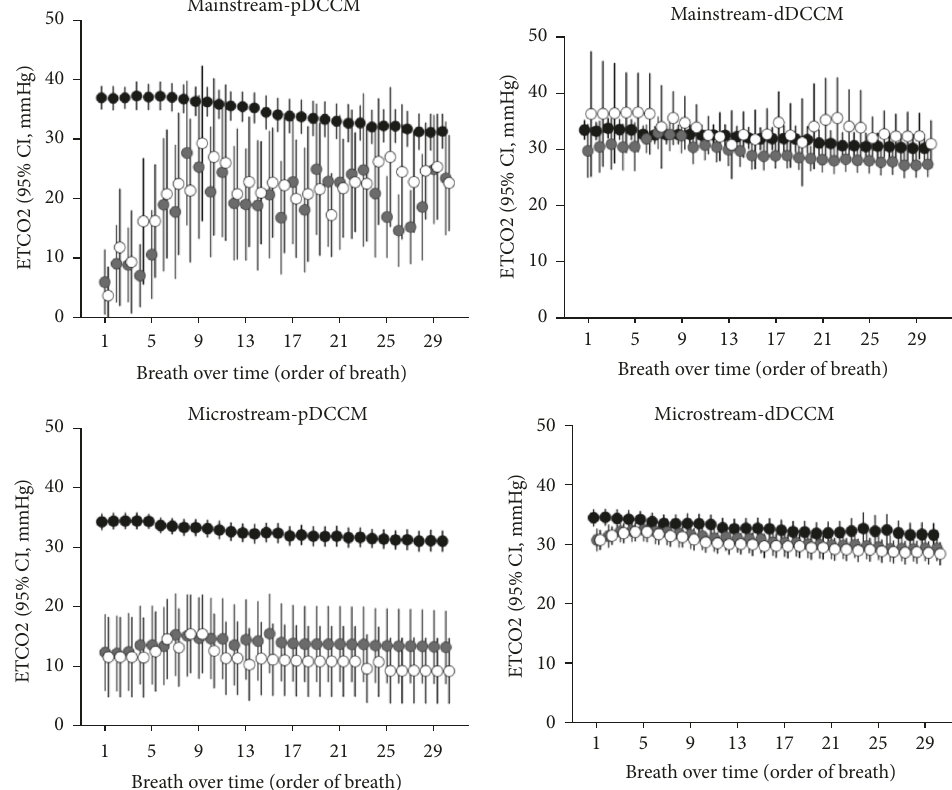
Figure 3: Individual ETCO for each breath over time measured by pDCCM and dDCCM under different water conditions (black circle - no 2 water, grey circle - 5 ml water, white circle - 10 ml water) created within the endotracheal tube . Individual ETCO2 values monitored from every breath over time were represented as mean with standard errors (95% CI) using error bars. Abbreviations: dDCCM, distal capnometer of direct connect catheter mount; ETCO 2 , End-tidal carbon dioxide; pDCCM, proximal capnometer of direct connect catheter